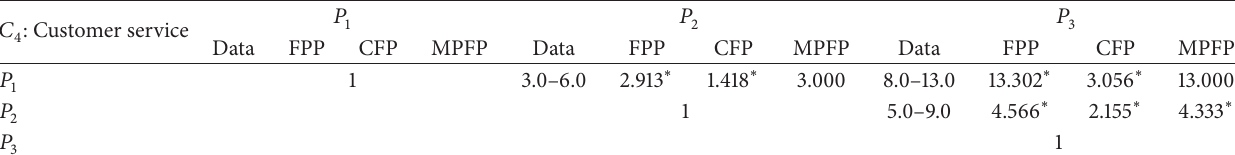
Table 8: Solution matrix of alternatives for 𝐶 4 (Example